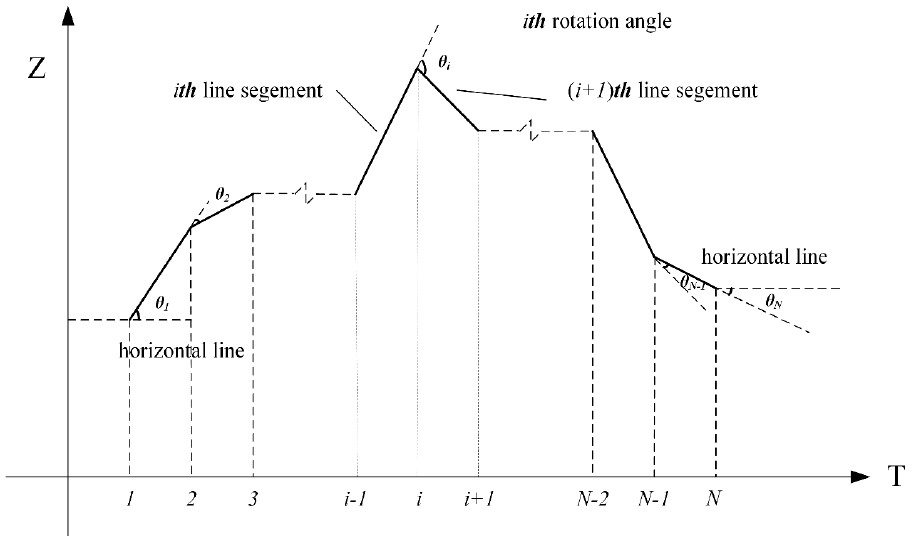
Figure 1. Diagram of rotation angle and line segment of the process.